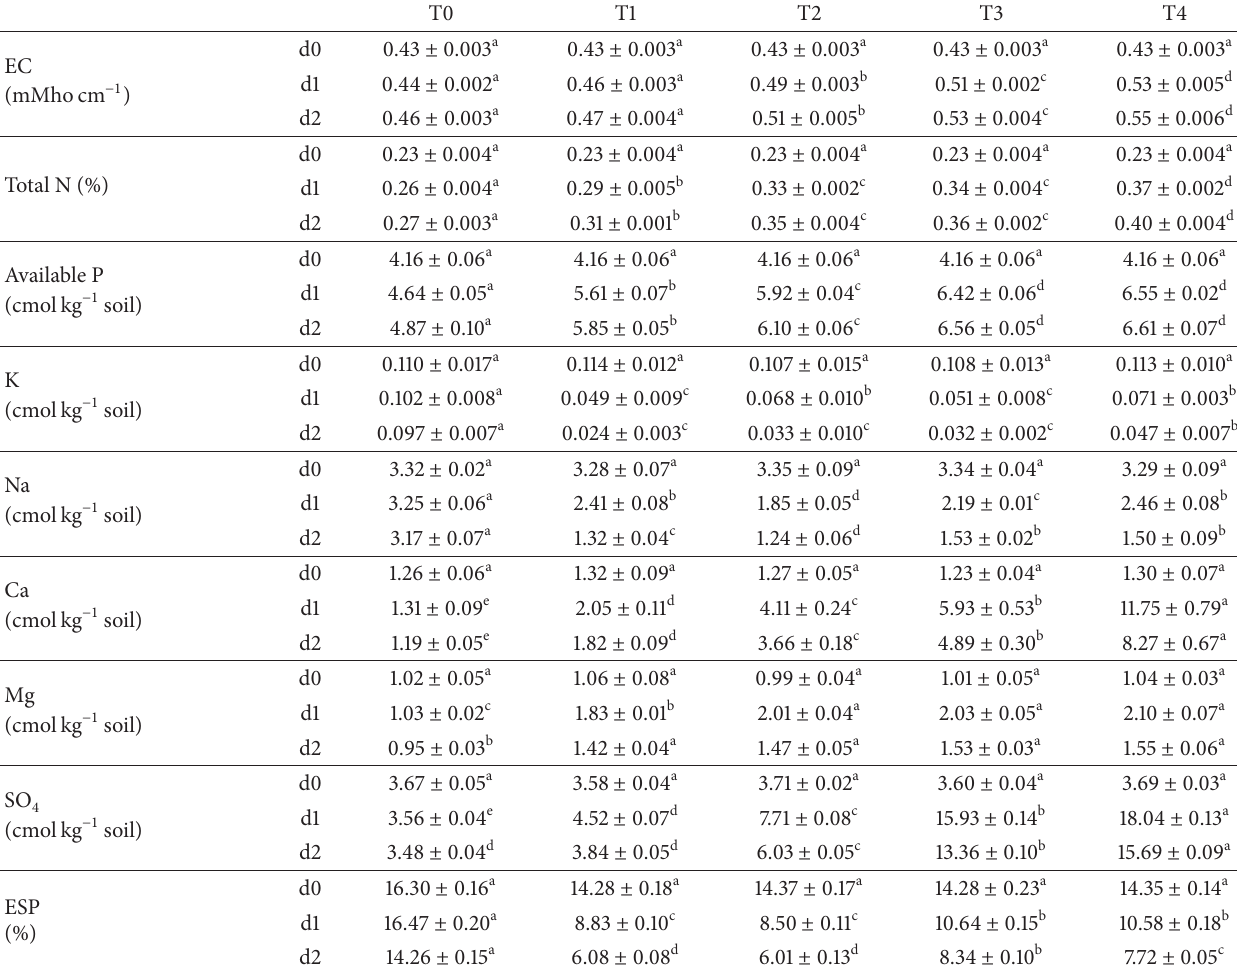
Table 8: Selected chemical properties and nutrient (cmolkg − 1 ) concentrations of different FGDB amended soils.